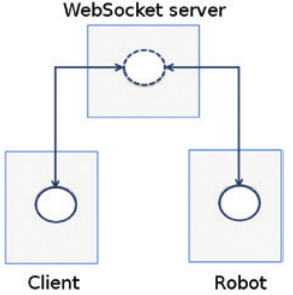
Figure 4: The WebSocket